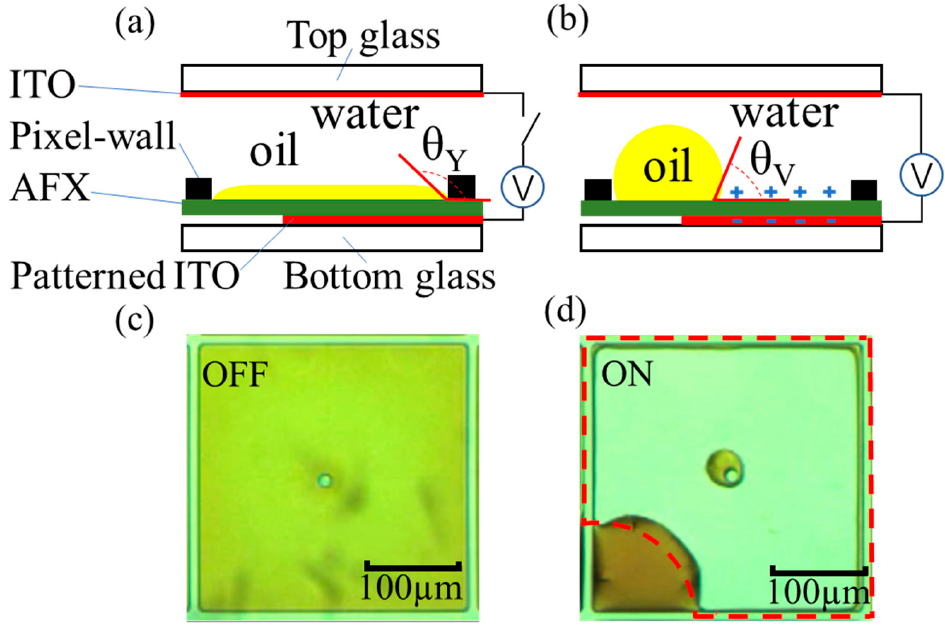
Figure 2. Operating principle of the EWD pixel. ( a ) Cross-sectional view of OFF state. ( b ) Cross- sectional view of ON state. ( c ). The microscope image of the pixel OFF state. ( d ) The microscope image of the pixel ON state.